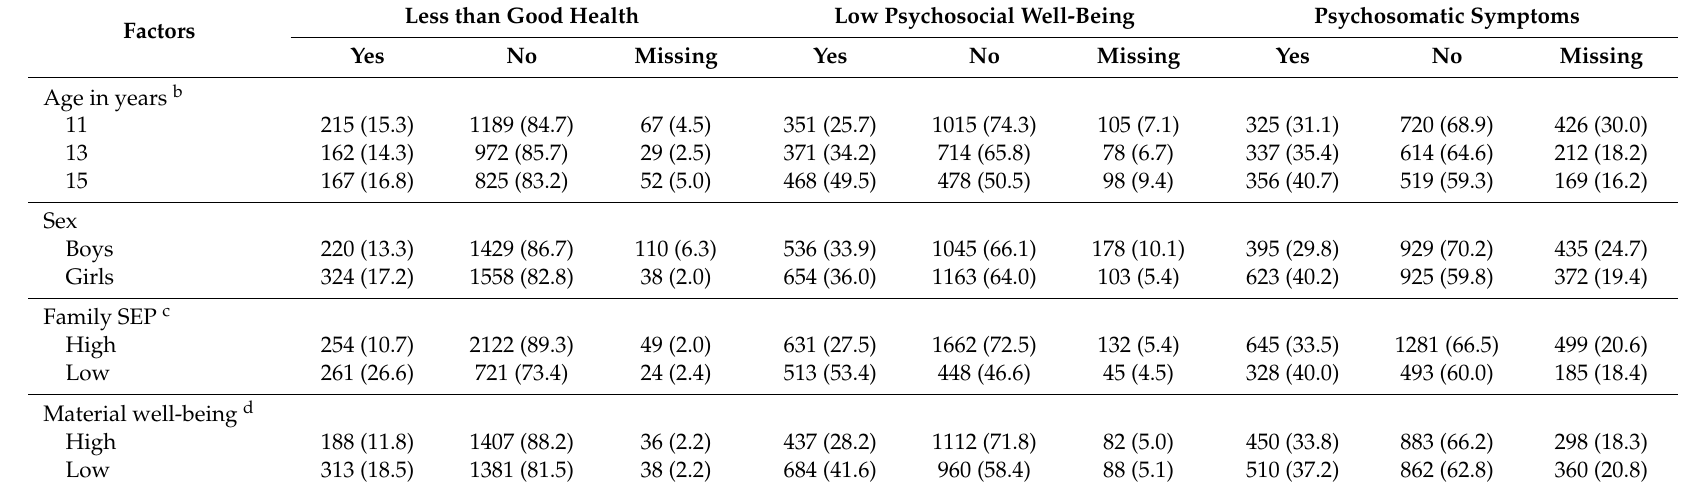
Table 2. Frequencies (percentages a ) of health outcomes by di ff erent demographic and socioeconomic characteristics. Less than Good Health Low Psychosocial Well-Being Psychosomatic Symptoms Factors